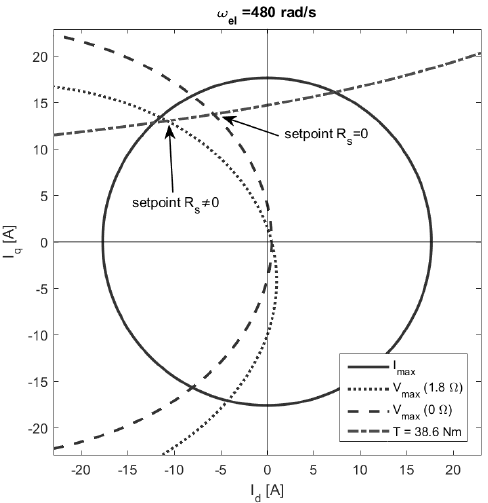
Figure 6. Visualization of optimal setpoints for rotor speed ω = 400 rad/s. The optimal setpoint lies on the intersection of the FW curve with the iso-torque curve (T = 38.6 Nm). FW curve with correct resistance ( R s = 1.8 Ω ) is compared to curve with neglected resistance ( R s = 0 Ω ).